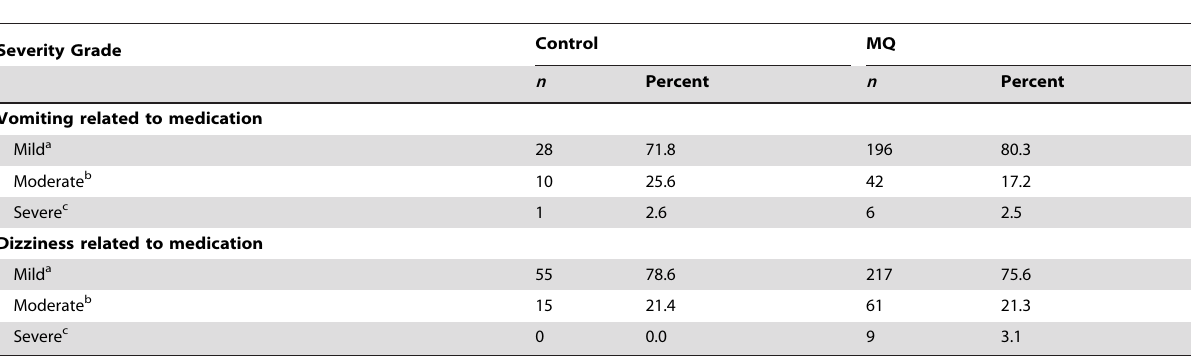
Table 9. Severity of reported vomiting and dizziness by treatment group.